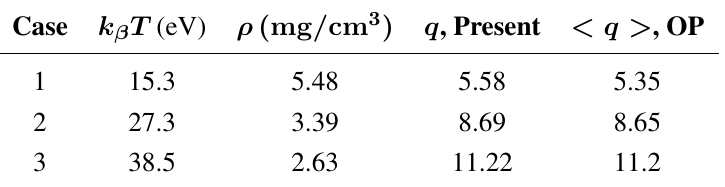
Table 7. Comparison of ionization stages q for Fe obtained in present calculations with mean ionization stages < q > from OP [38].